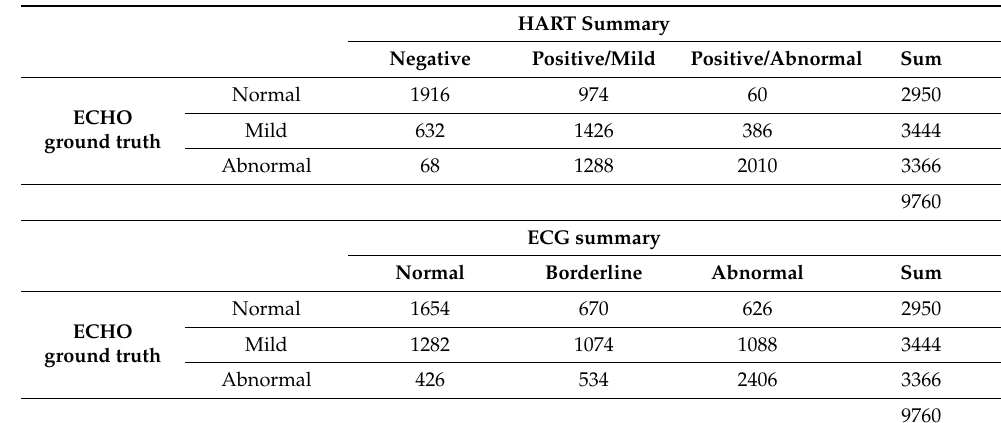
Table 1. Confusion matrix of Triple Aggregated Diagnostic of HART Summary and ECG.